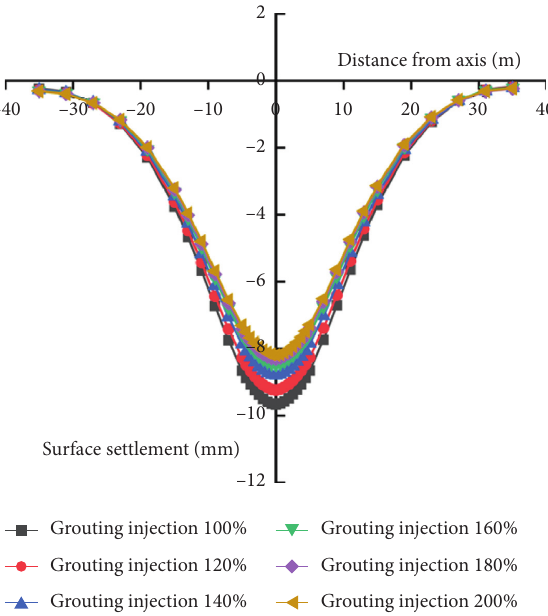
Figure 13: Surface settlement under different grout injection rate conditions.